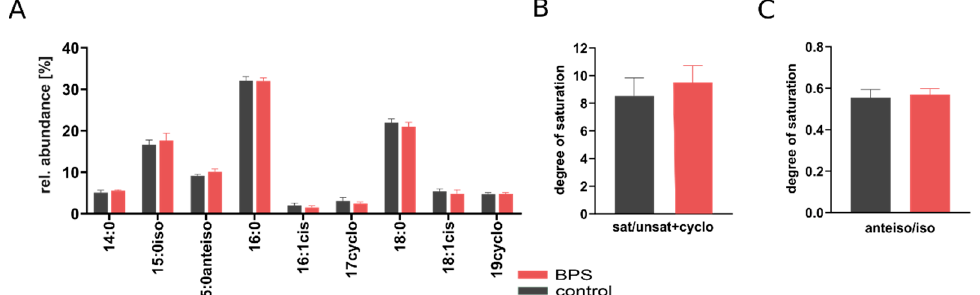
Figure 4. ( A ) The relative abundance of membrane fatty acids in BPS treated and control bioreactors based on the average concentrations at day 13 and 14 ( n = 6). Degree of saturation of the membrane of SIHUMIx based on the ratio of saturated to unsaturated and cyclopropyl fatty acids ( B ) and on the ratio of anteiso- and iso-methyl-branched fatty acids ( C ). No statistical differences were found between BPS-treated and control samples.